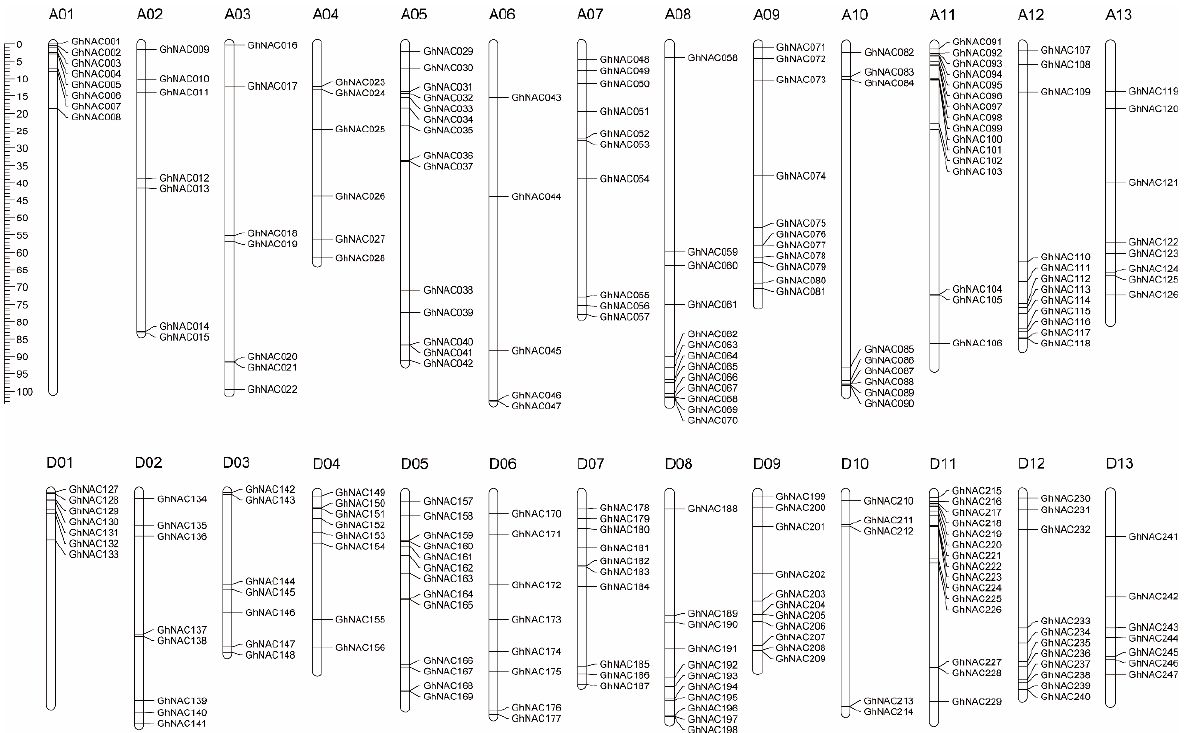
Figure 2. Chromosomal locations of the GhNACs . Scale bar on the left indicates the chromosome lengths (Mb). The chromosome numbers of G. hirsutum L. (A01–A13, D01–D13) are indicated above each vertical bar.